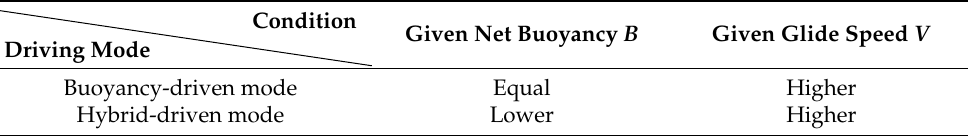
Table 2. Comparison of the zero-angle-of-attack glider’s sailing efficiency with traditional glider at the same glide angle. Condition Given Net Buoyancy B Given Glide Speed V Driving Mode Buoyancy-driven mode Equal Higher Hybrid-driven mode Lower